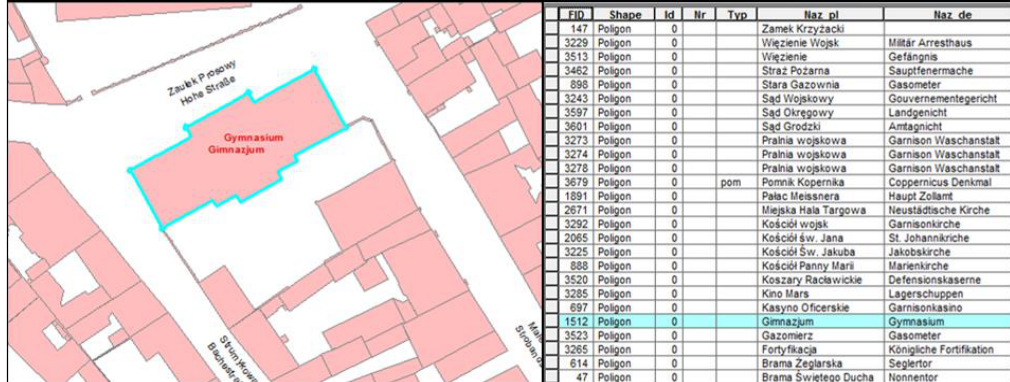
Figure 12. The structure of the attribute table with the highlighted row and the corresponding building of the secondary school on the example of the “built - up area” information layer.